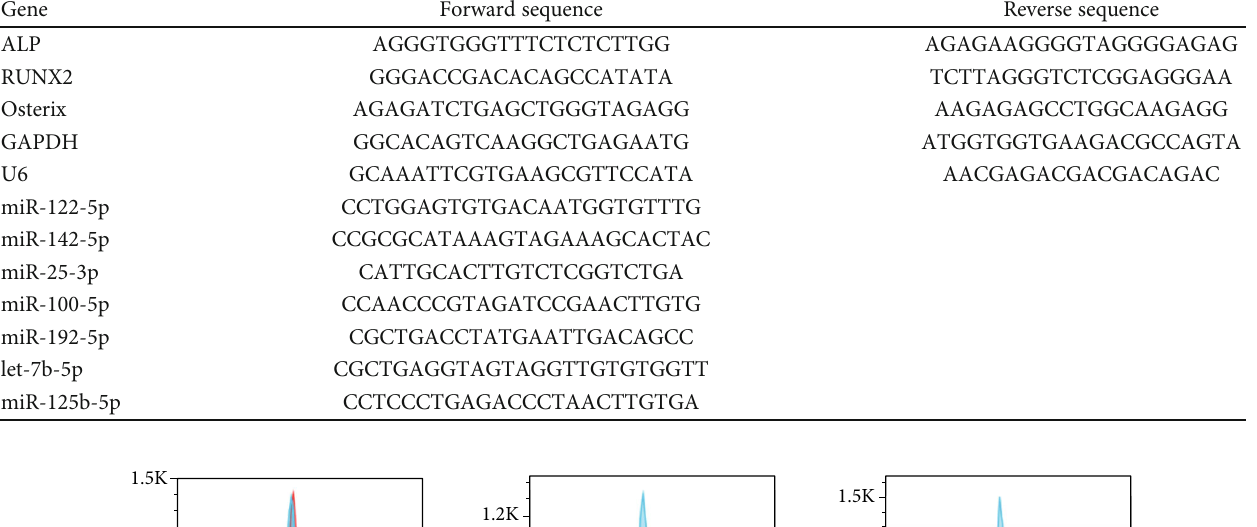
Table 1: List of gene primers.